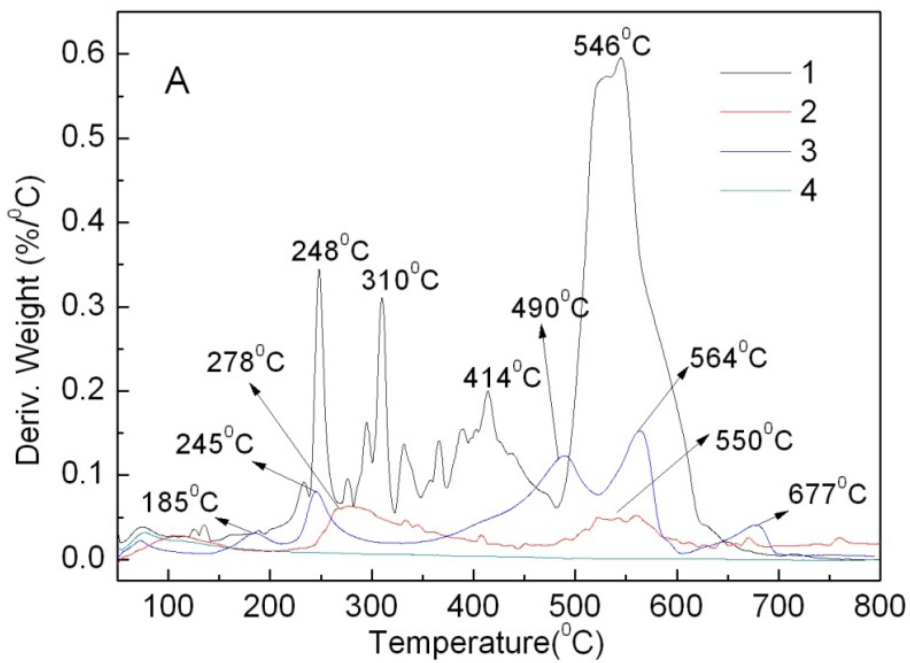
Figure 7. FTIR spectra of the ABB6B ( 1 ), the Ca